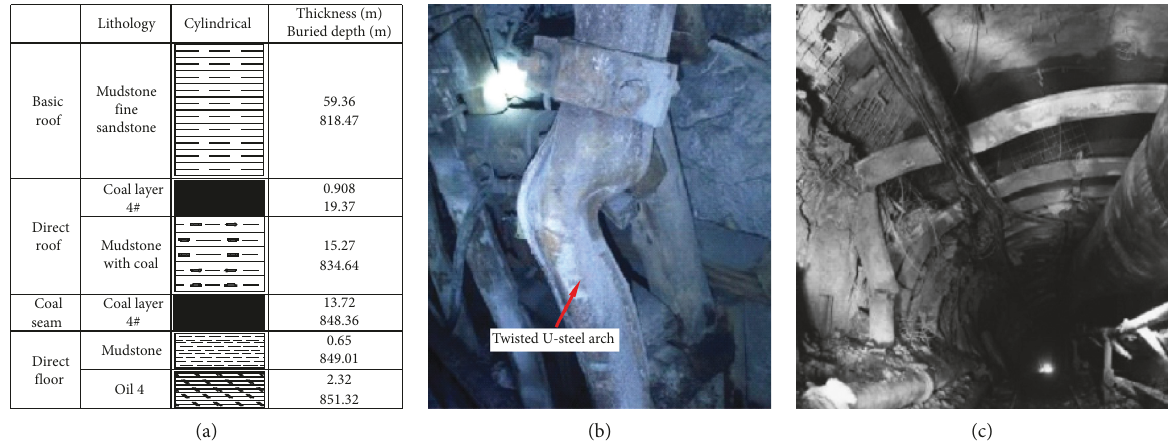
Figure 1: Deformation and failure situation of the 4606 roadway. (a) Stratum profile. (b) Twisted U-steel arch leg. (c) Global deformation of the roadway and supporting arch. Scheme